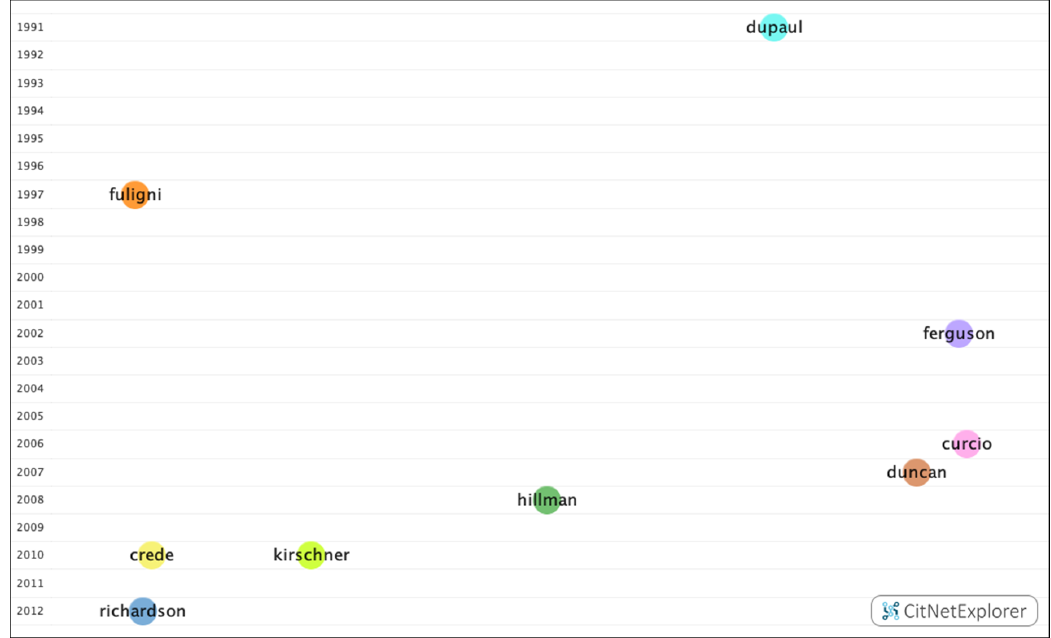
Figure 16. Relationship between the nine major groups.